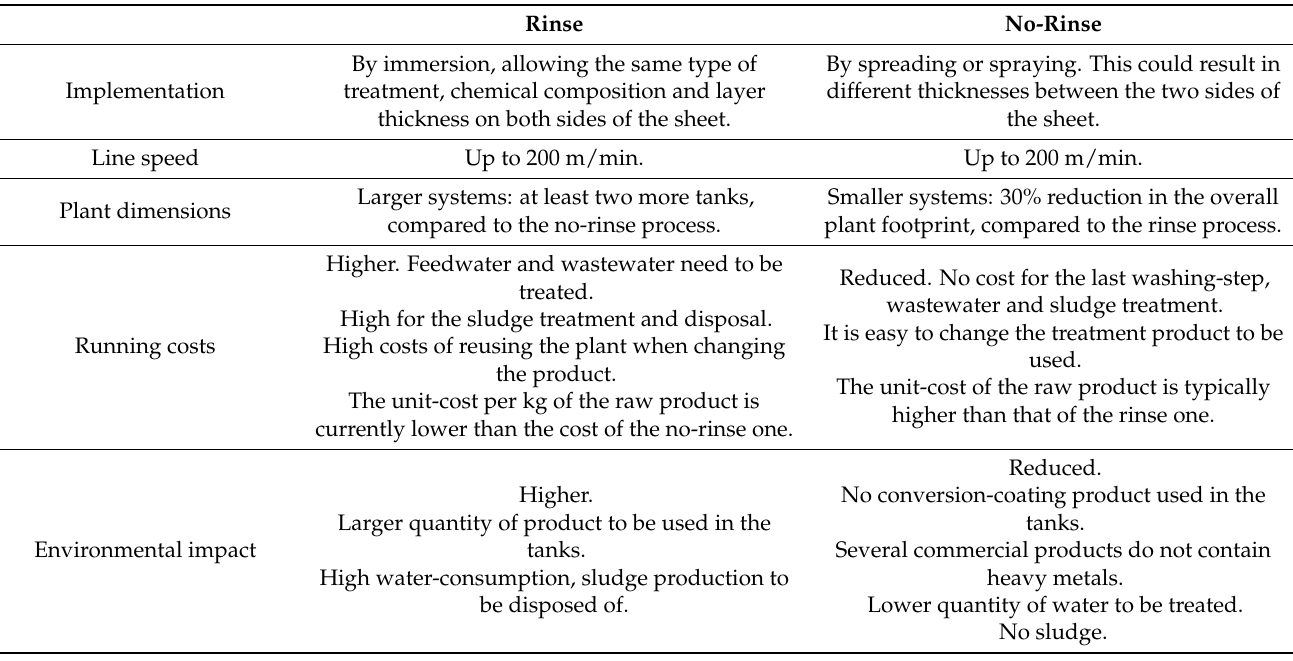
Table 1. Benefits and drawbacks of rinse and no-rinse process.